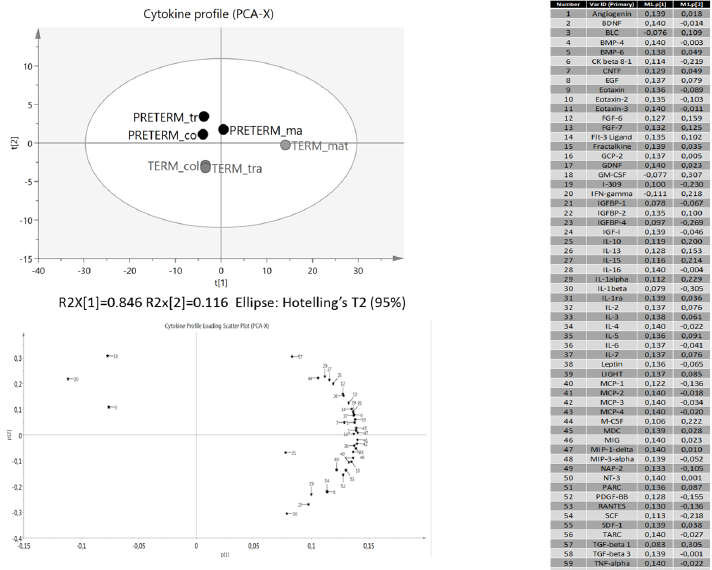
Figure 5. Principal Component Analysis (PCA) and Loading Scatter Plot of cytokine profile ( n = 60 cytokines) obtained by protein arrays from milk samples. By comparing the score and loading plot, the relationships between cytokine profiles and samples (term and preterm during lactation) could be identified.